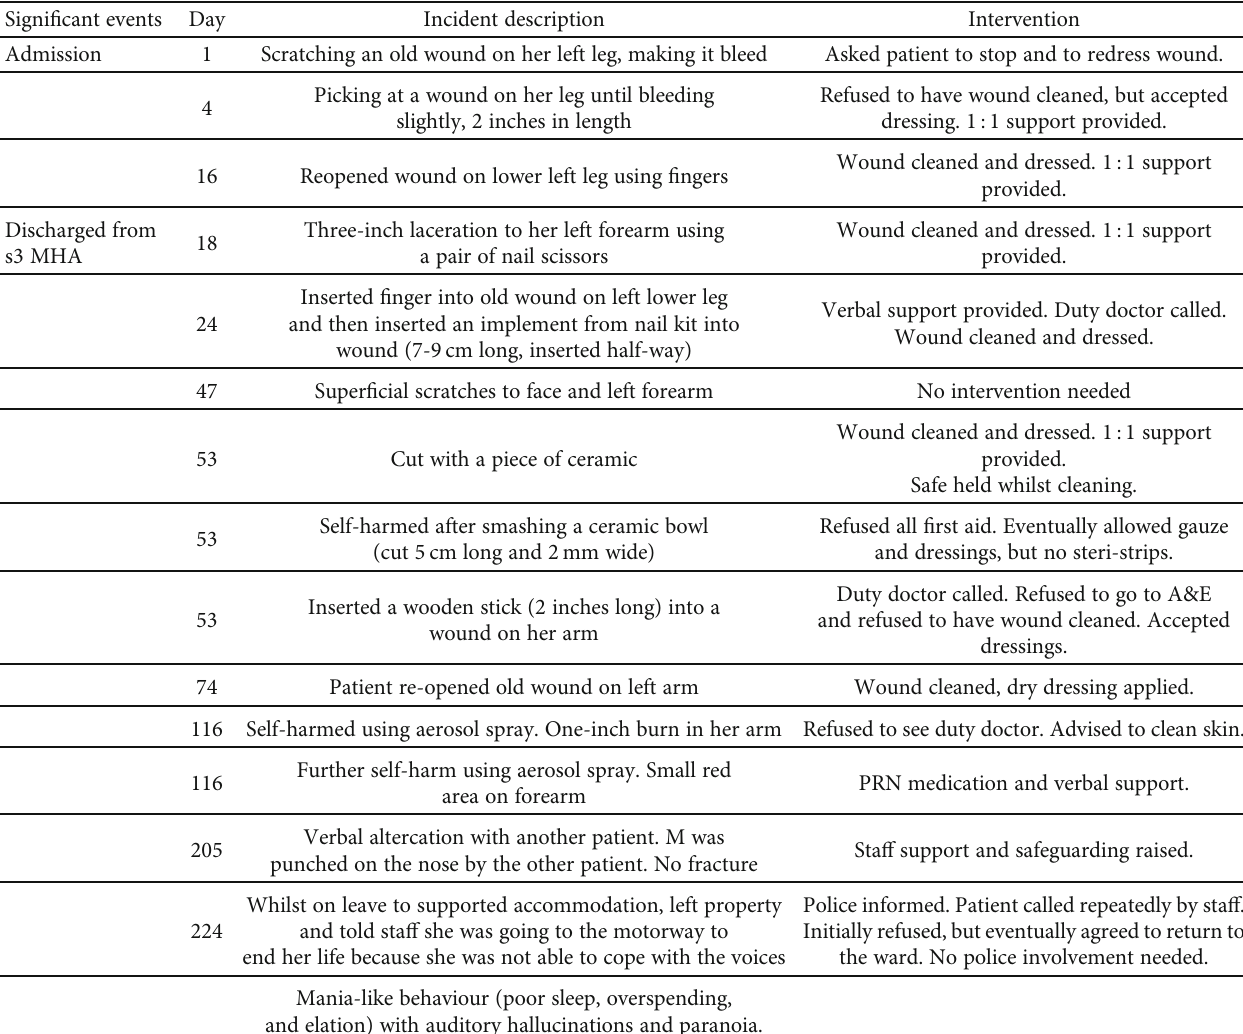
Table 2: Summary of incidents and interventions during Springbank admission. There were no major complications from any intervention (or lack of intervention), apart from the pain, bleeding, and scarring from the wounds and limited skin infections that responded to antibiotics. A&E refers to the accident and emergency